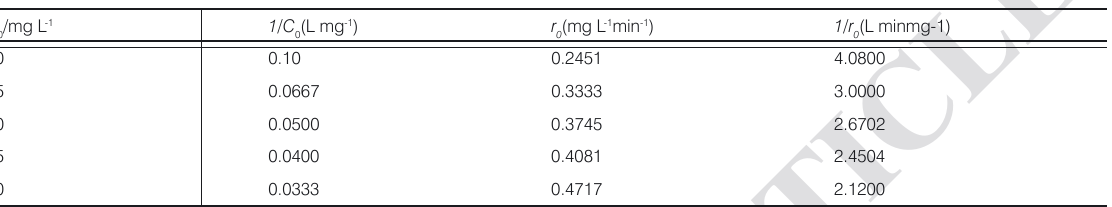
Table 2. Relating kinetic parameters on the photo-degradation of